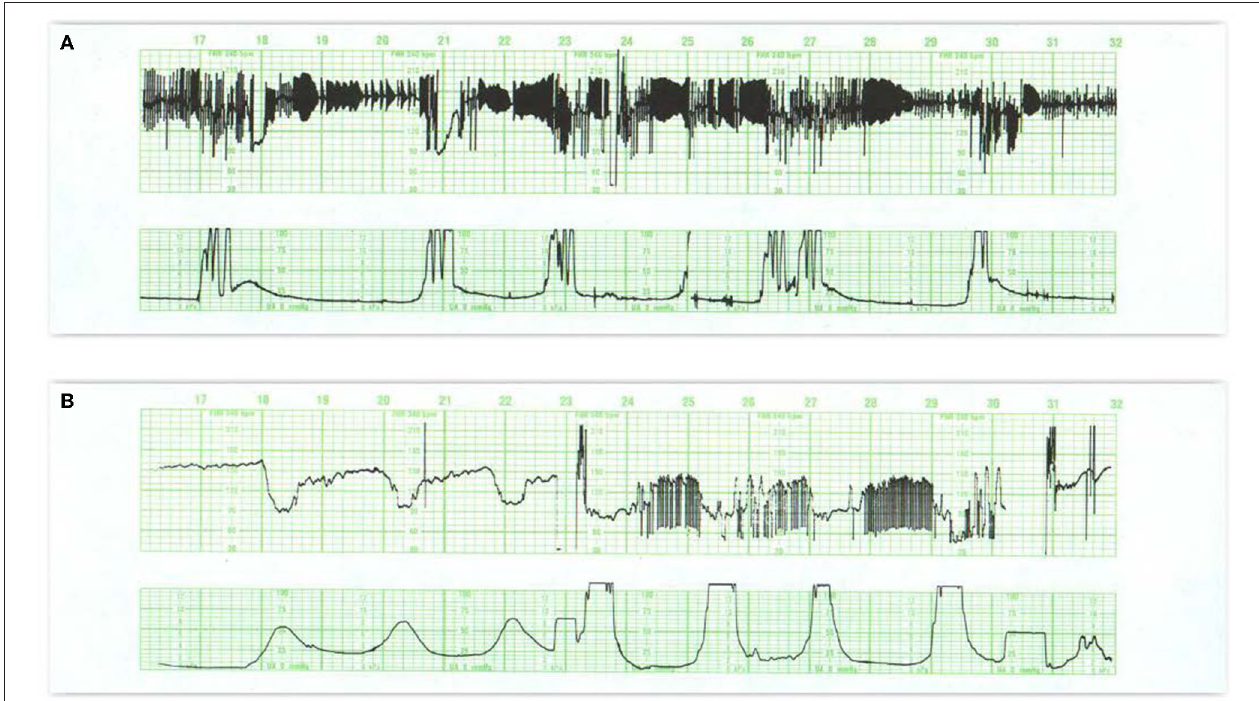
FIGURE 6 | (A) Reveals a fetal arrhythmia—not artifact. Note the recurrent, symmetrical geometric patterns produced by clusters of ectopic beats. This pattern results from cardiac bigeminy (alternating intervals), with the shorter interval getting progressively longer and the longer interval getting progressively shorter. Notice that all of the changes are contained within a narrow range of heart rates (really intervals). These ectopic ventricular beats are multifocal (different heights, different patterns) and frequently alternate with normal beats. Notice the occasional decelerations at 18M and 21M. Although the tracing reveals a stable heart rate and probably inconsequential variable decelerations, the frequency of the ectopic beats precludes estimation of the amount of beat-to-beat variability. This tracing mandates ultrasound examination of the fetus to rule out hydrops or congenital anomaly. A pediatrician should be present in the delivery room to assist with any resuscitation. (B) Illustrates variations on the theme of second stage decelerations. Variable decelerations appear with each contraction. After the onset of pushing (24M), the decelerations are followed by an arrhythmia at the end of the deceleration. These excursions are restrained, limited, create geometric (bigeminal) patterns, and are restricted to the period between contractions. In this situation, the patient should refrain from pushing until the character of the heart rate pattern has defined itself